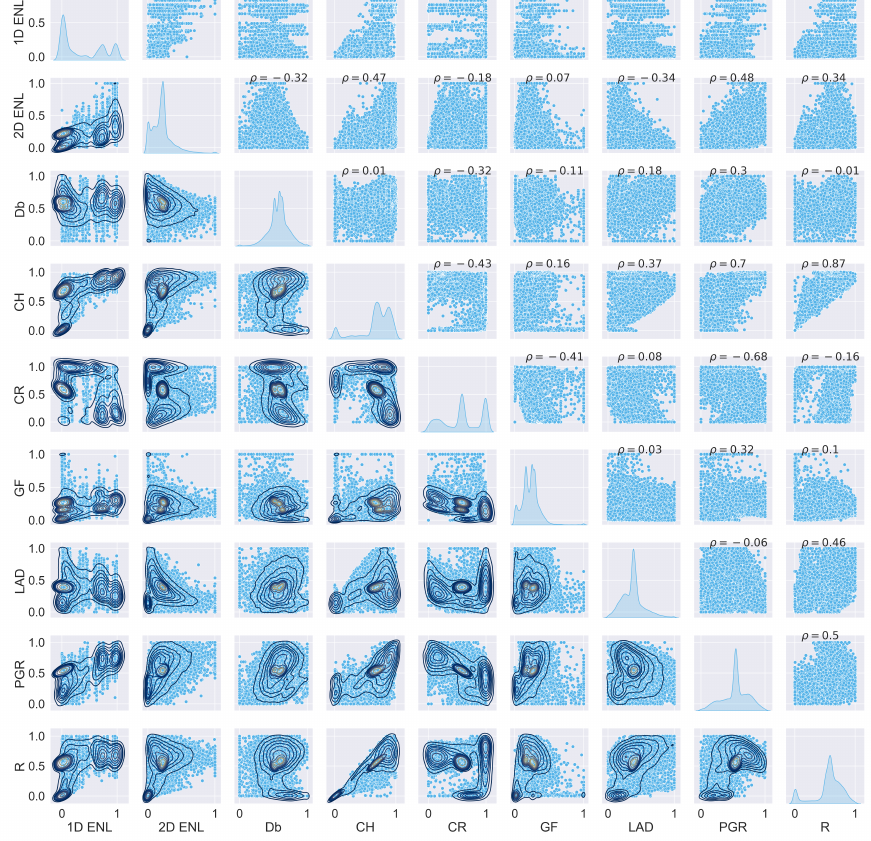
Figure A1. Scatterplot matrix of ULS traits at 0.5 m grid